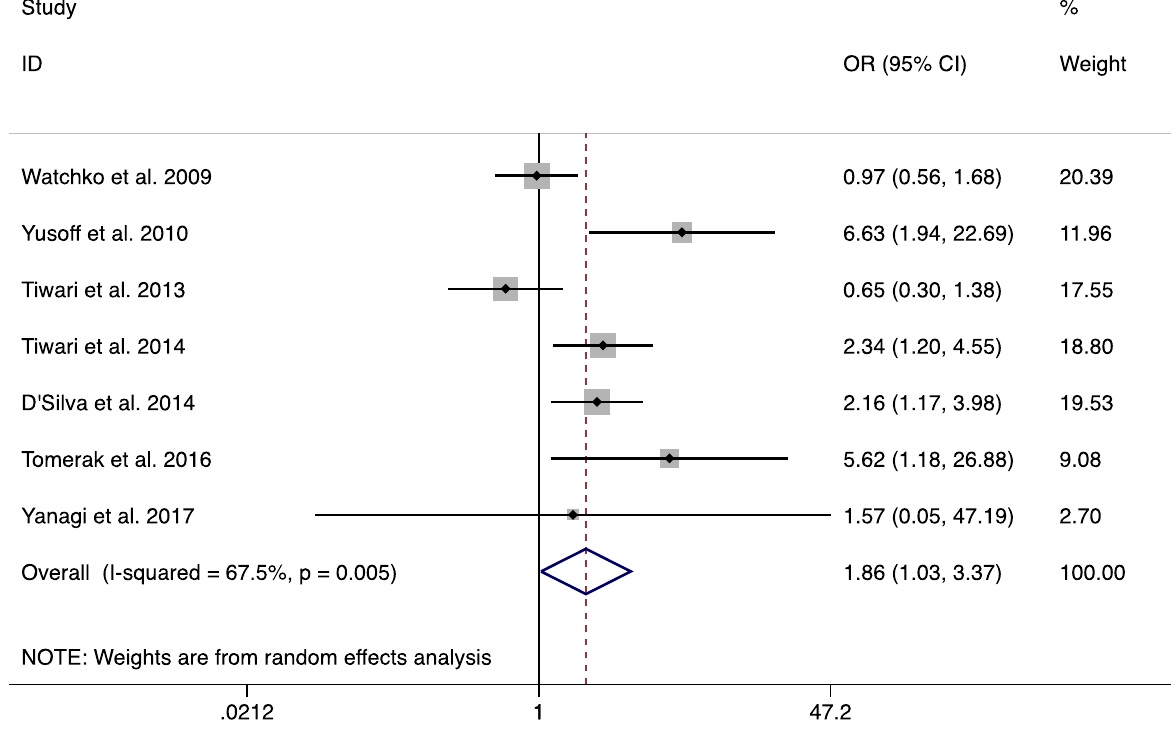
Fig. 2 Random-effects meta-analysis on NNH risk and c.-3279 T > G (rs4124874) polymorphism in overall population (GG versus